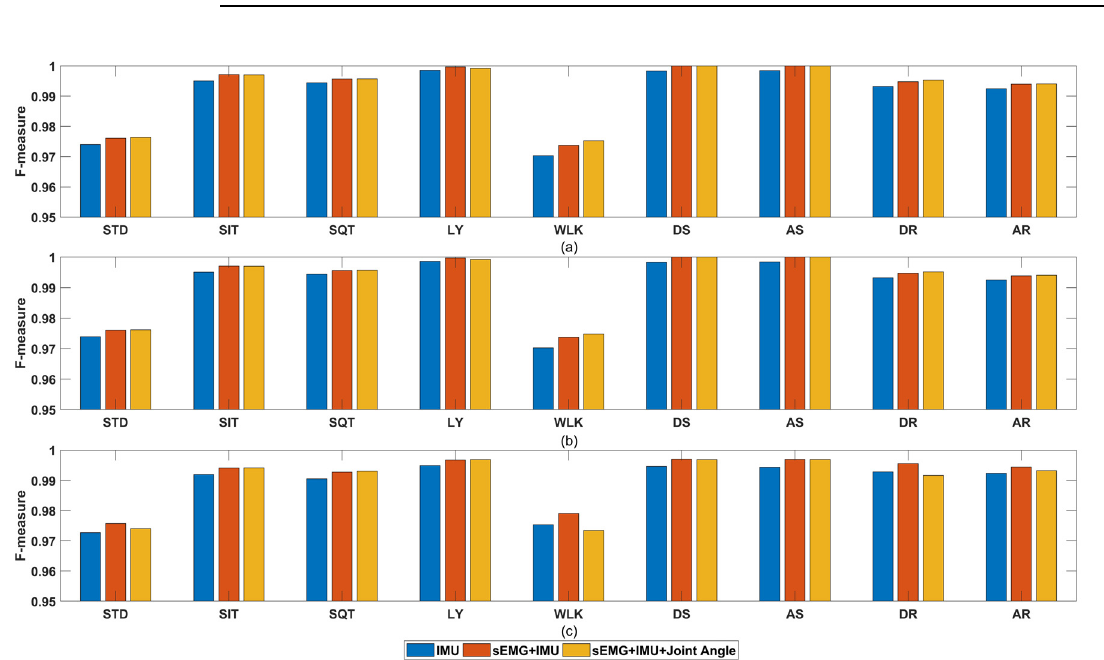
Figure 10. Mean F-Measure per activity and multiple sensors combination with different classification algorithms: ( a ) KNN; ( b ) RF; ( c ) SVM.